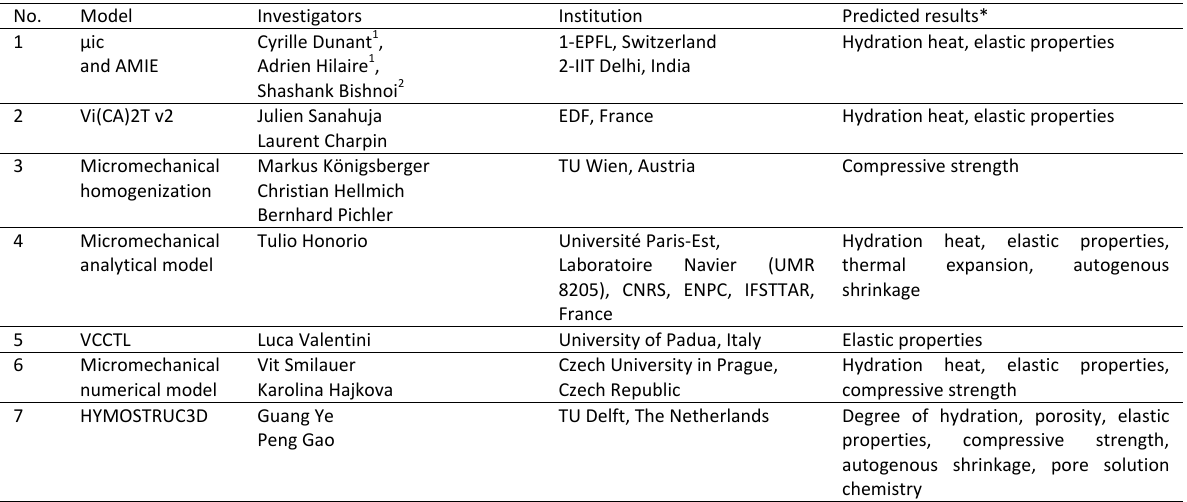
Table 1. Participants of the benchmark and models